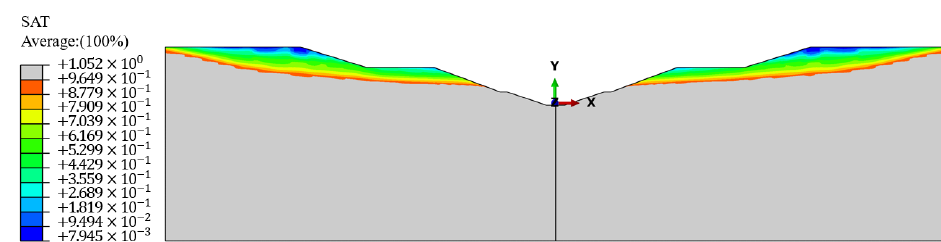
Figure 8. Canal saturation contour when t = 10 years.